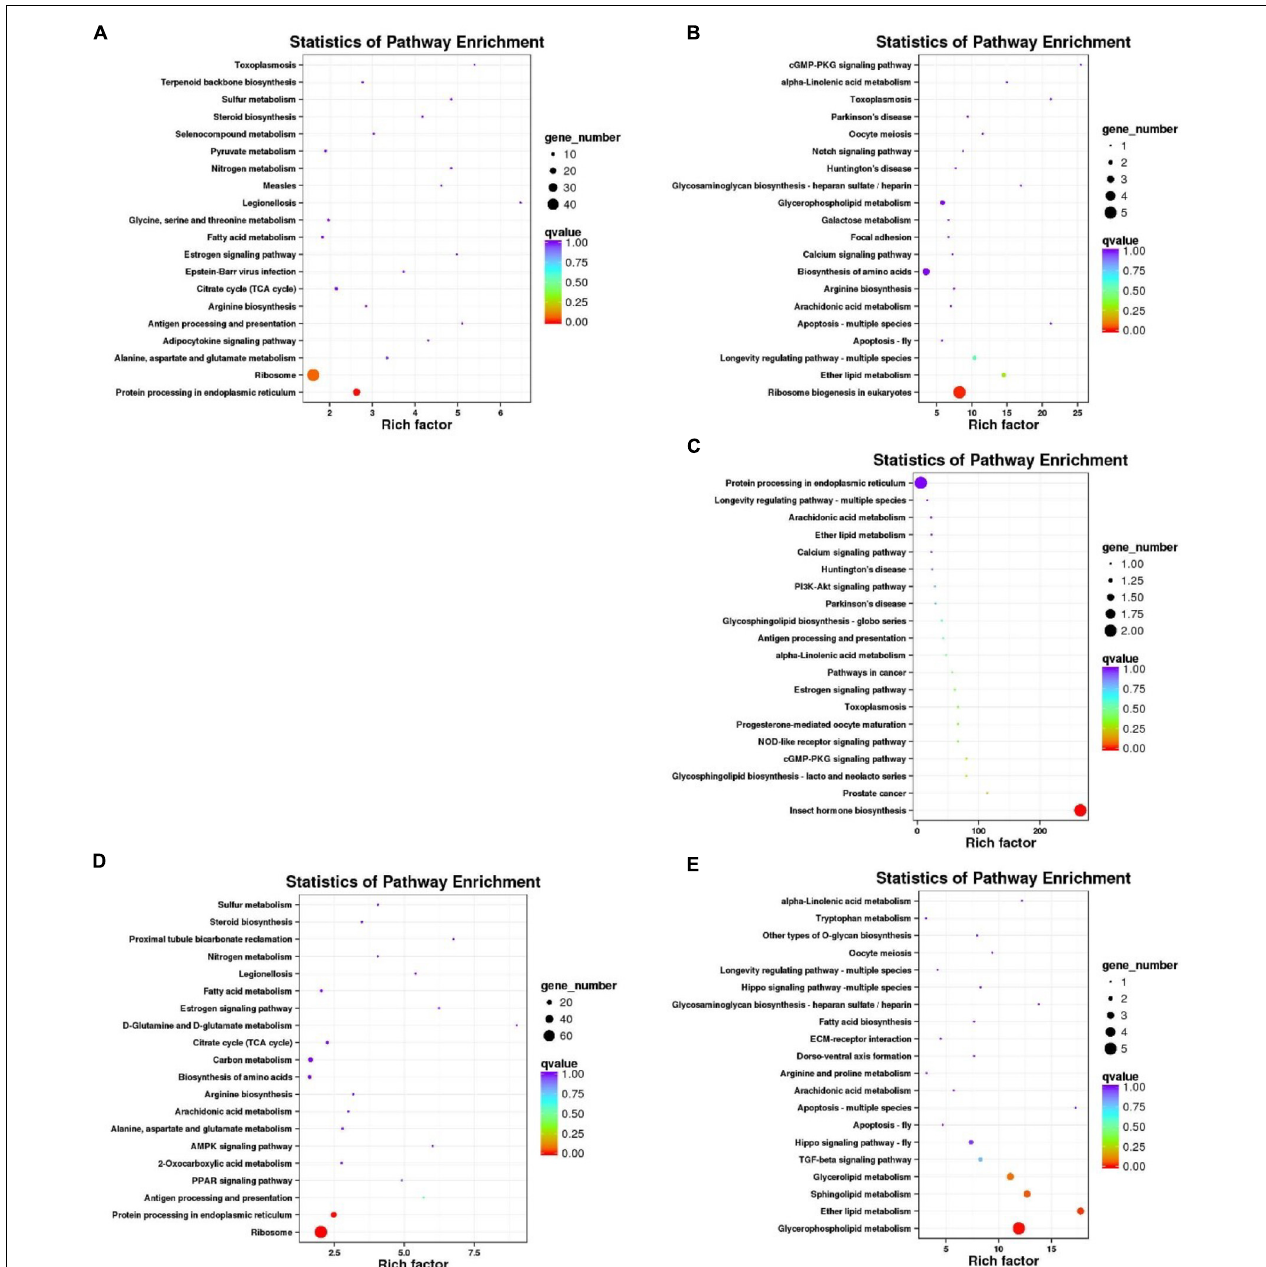
FIGURE 4 | KEGG pathway enrichment analysis of DEGs of C. japonica exposed to three temperature gradients. KEGG pathways of (A) C. japonica unigenes up-regulated and (B) down-regulated at 28 ◦ C compared with 20 ◦ C; (C) C. japonica unigenes down-regulated at 12 ◦ C compared with 20 ◦ C and (D) C. japonica unigenes up-regulated and (E) down-regulated at 28 ◦ C compared with 12 ◦ C.